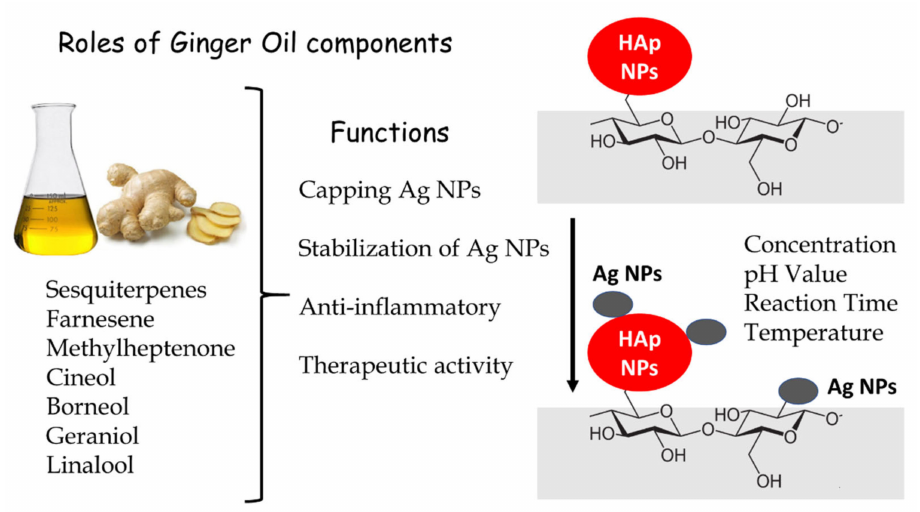
Figure 4. Schematic representation showing Ag NP phytosynthesis on the surface of HAp NP-coated cotton gauze in which the reducing agent was ginger oil, a green chemical with anti-inflammatory and therapeutic